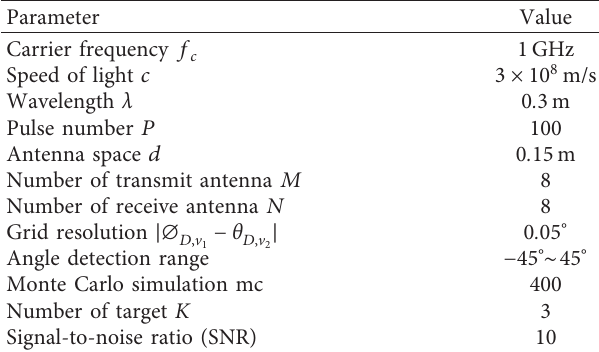
Table 1: Simulation parameters.